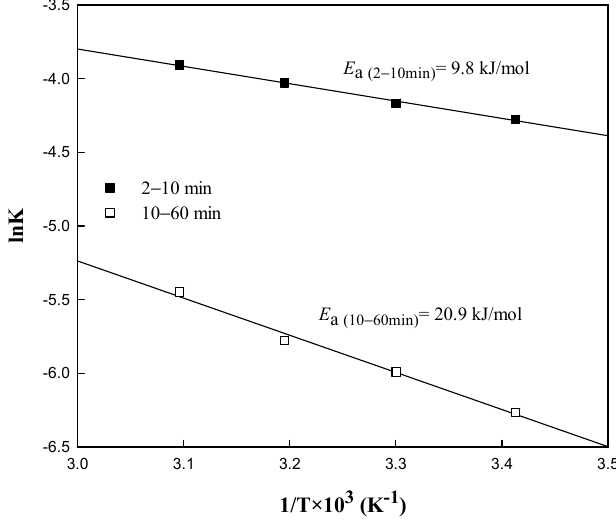
Figure 10. Plot of lnK versus 1 / T to obtain the apparent activation energy.